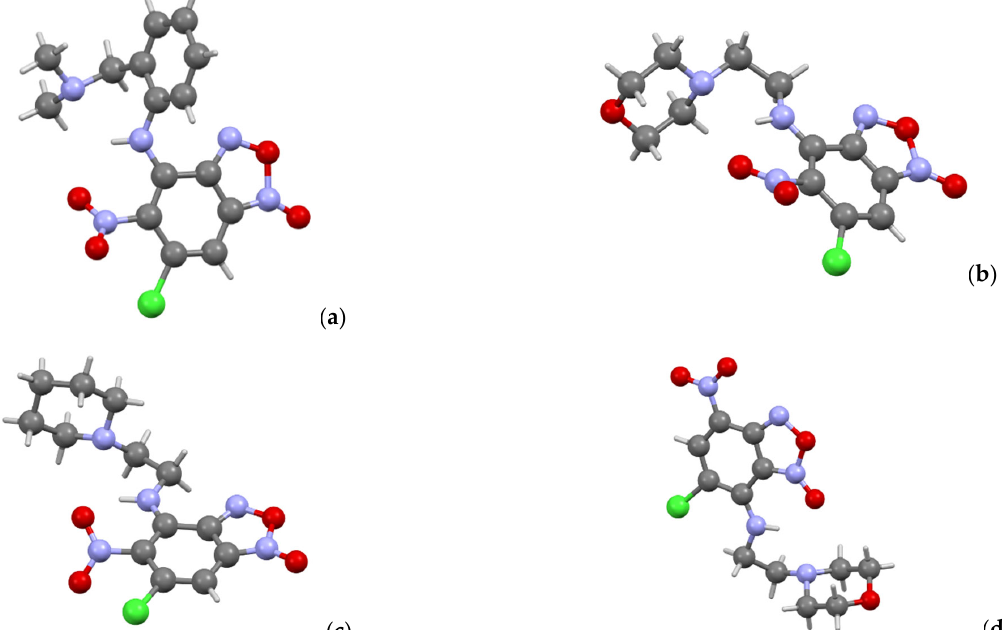
Figure 1. Molecular structures of compound 3 а ( a ), 3d ( b ), 3f ( c ) and 5d ( d ).